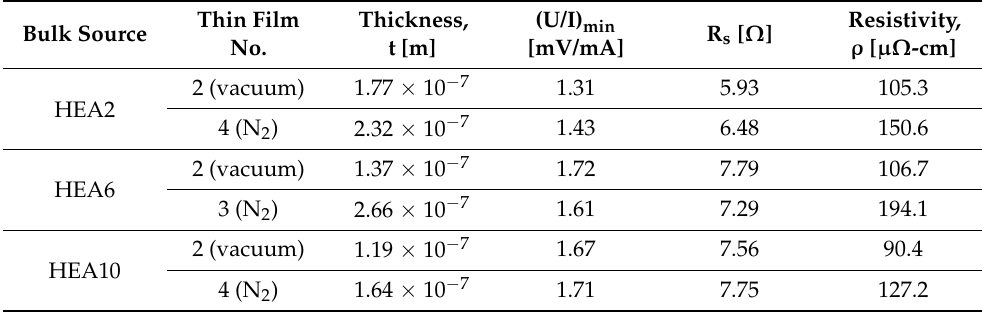
Table 3. Summary of HEA and HEN thin films thicknesses, values of U/I min and